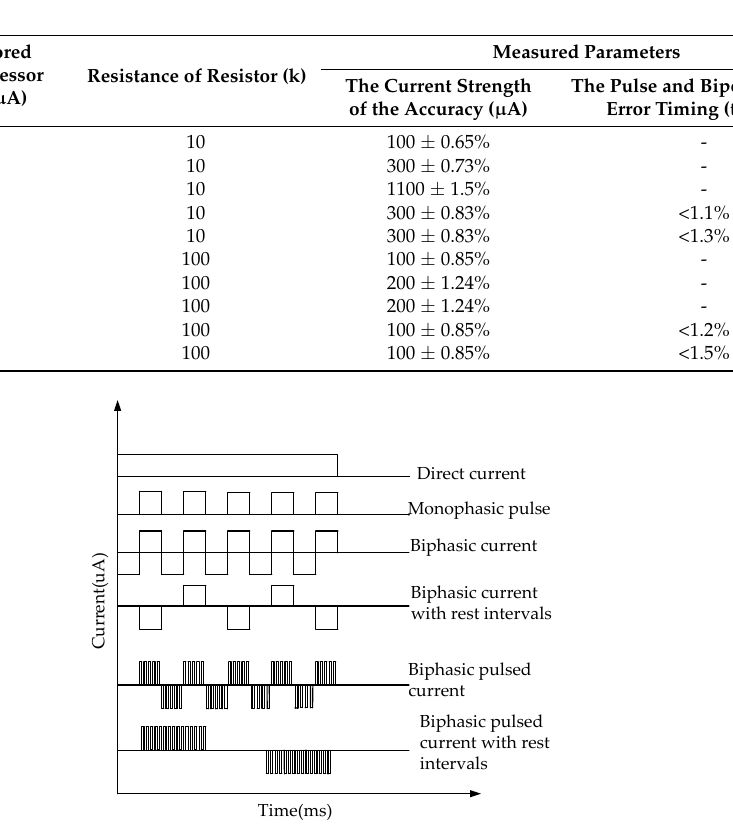
Figure 6. Output waveform of the reverse iontophoresis’s circle.